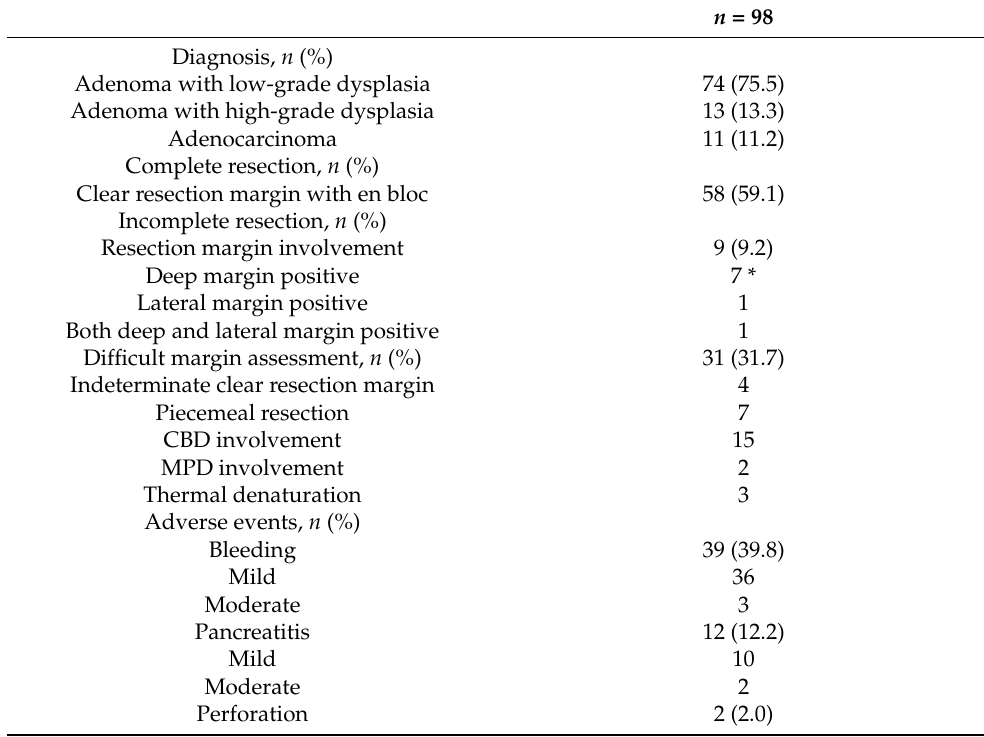
Table 2. Pathological outcomes and adverse events after endoscopic